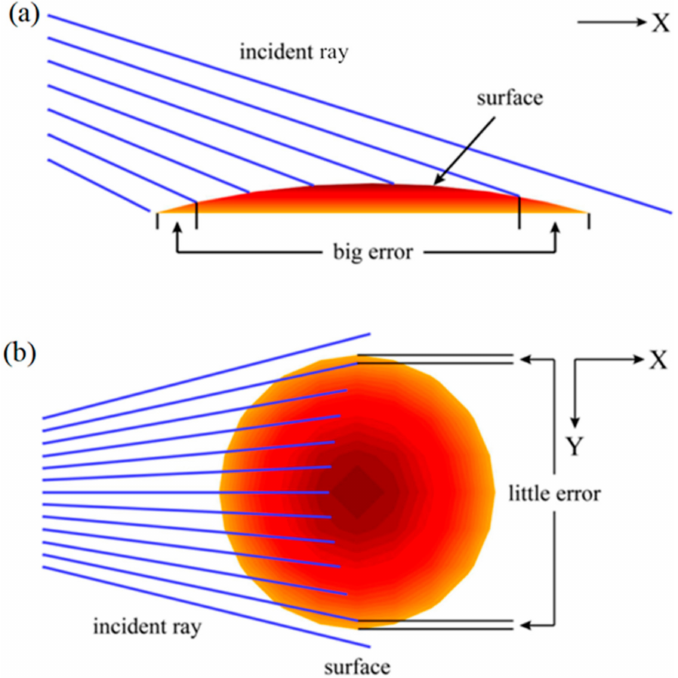
Figure 4. The sketch of the error analysis in X and Y directions. ( a ) The error analysis in X direction; ( b ) the error analysis in Y